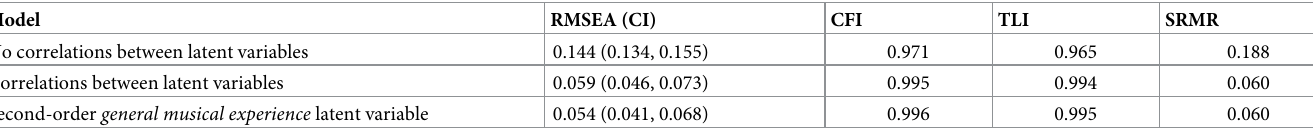
Table 3. Fit indices for the three measurement models of lifetime musical experience.